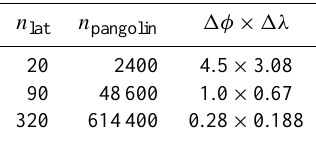
Table 5. Some Pangolin configurations, with the number of lati- tudes on a hemisphere n lat , total number of cells n pangolin and res- olution at the Equator in